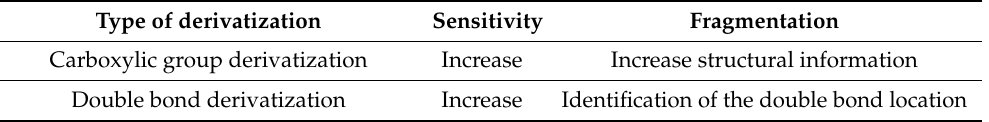
Table 3. Advantages of derivatization for the analysis of